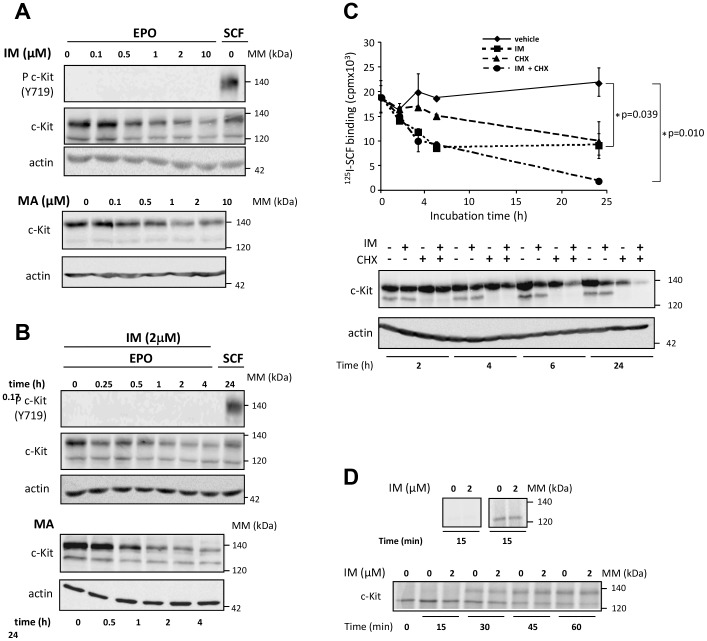
Imatinib or masitinib induces the down regulation of c-Kit but does not influence c-Kit neosynthesis and stability.
A and B. Expression of mature (140 kDa) and immature (120 kDa) forms of c-Kit. UT-7/Epo cells were incubated with indicated concentrations of imatinib (IM) or masitinib (MA) for 4 h or with 50 ng/ml SCF for 10 min (A) or with 2 µM IM or MA for indicated times (B). Phospho c-Kit (Tyr719) and c-Kit were revealed by immunoblot and actin was used as loading control. All data are representative of at least three independent experiments. C. Effect of protein synthesis inhibitor cycloheximide and imatinib on the expression of cell surface functional c-Kit. UT-7/Epo cells were incubated with 2 µM imatinib (IM) or vehicle, in the presence or absence of 500 µM cycloheximide (CHX) for 24 h. At indicated times, cells were labeled with 200 ng/ml [125I]SCF for 90 min at 4°C and the radioactivity was determined and expressed as absolute values. Results are the mean of three independent experiments. Alternatively, cell lysates were analyzed for c-Kit expression by immunoblot (lower panel). Actin is used as loading control. D. c-Kit de novo synthesis and maturation. C-Kit de novo synthesis was analyzed in the upper panel UT-7/Epo cells (5.105) were preincubated for 4 h in the presence or absence of 2 µM imatinib (IM) and then labeled with [35S]Met/Cys-containing medium for 15 min at 37°C. Immunoprecipitation (IP) was performed using isotypic control (left panel) or anti-c-Kit antibodies (right panel). C-Kit maturation was studied on lower panel. UT-7/Epo (5.105) cells were pulse-labeled with [35S]Met/Cys for 15 minutes and chase followed by c-Kit immunoprecipitation using anti-c-Kit antibodies was done for indicated times after incubation with IM (2 µM) or vehicle. Labeled c-Kit was revealed by fluorography. Results are representative of three independent experiments.